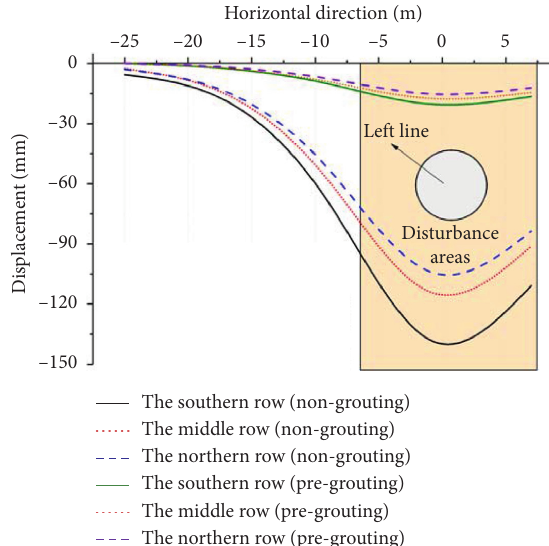
Figure 27: Simulated displacement distributions of building foundation after construction.